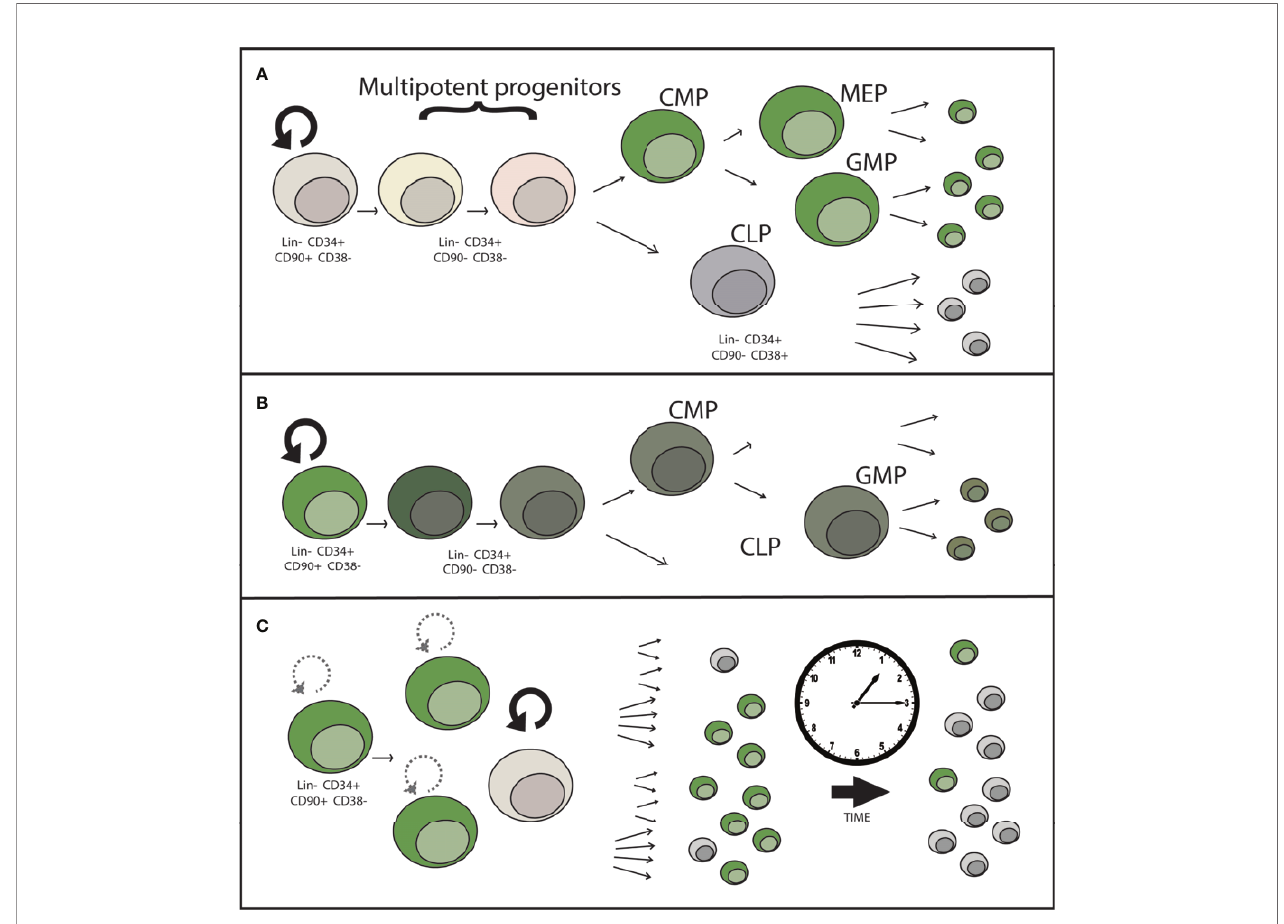
FIGURE 2 | Potential mechanisms for loss of gene-edited HSPCs over time after engraftment. (A) LT-HSCs may be less permissive to HSC transduction than committed progenitors due to differential expression of AAV attachment, entry, or restriction factors. This potential progenitor-biased transduction would lead to dilution of the proportion of edited hematopoietic cells over time over time, as shorter-lived progenitor cells reach the end of their lifespan. (B) Toxicity within the LT- HSC or progenitor cell population in response to AAV causes a loss of differentiation potential or cell death leading to incomplete reconstitution of gene edited cells over time. (C) Decrease in the self-renewal capacity of LT-HSCs over time causes a loss of gene-edited LT-HSCs over time, eventually causing loss or near complete loss of the HSC population contributing to hematopoiesis that contains the genetic